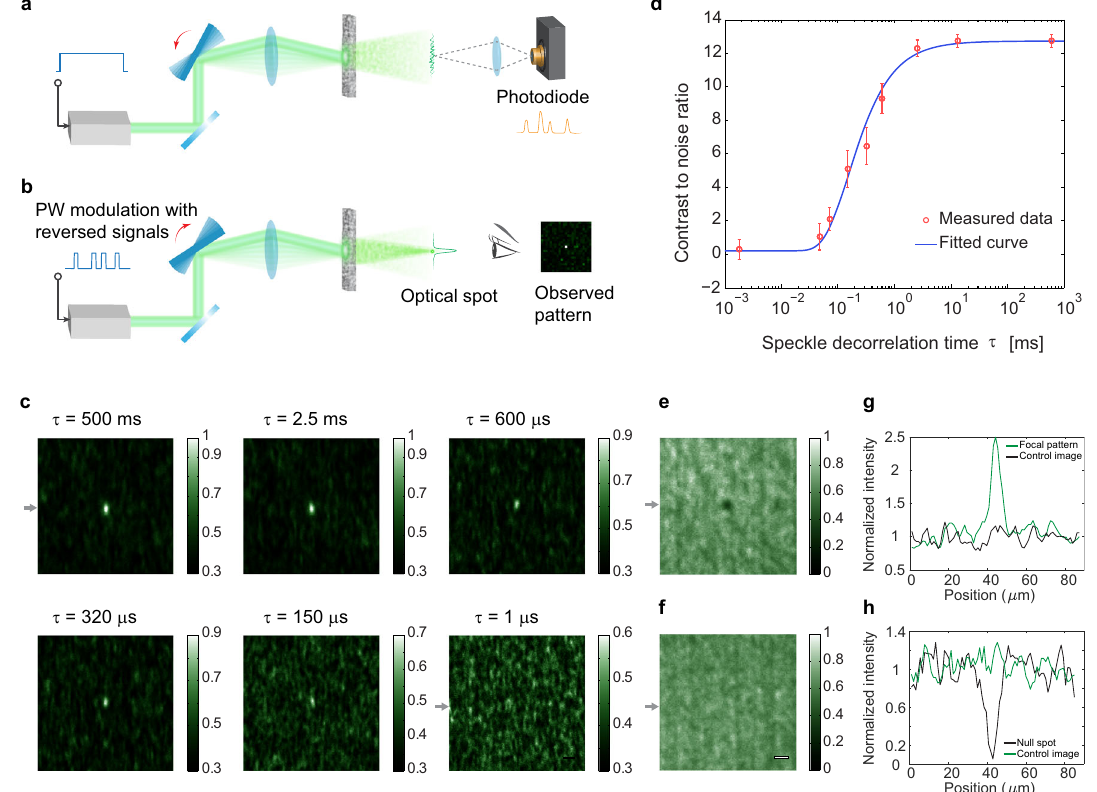
Fig. 3 Results of the feedback-based OCIS. a Simpli fi ed system setup for measurement. A galvo mirror was used to steer light into different channels of the scattering sample. As the galvo mirror scanned forward, the photodetector measured the temporal signal that fl uctuated as light (continuous wave) coupled into different channels. b The measured signal was binarized and used to modulate the intensity of the laser in a time-reversed order as the galvo mirror scanned backward. In this case, we can measure the optical channels and inject light (PW, pulsed wave) into the bright channels during a galvo mirror round trip. c At different sample decorrelation times, optical spots were created in free space and captured by a camera with an exposure time of 125 μ s. The CNRs for τ from 500 ms to 1 μ s are 12.6, 12.3, 9.3, 6.5, 5.1, and 0.3. Scale bar: 20 μ m. d CNR as a function of the sample decorrelation time. The error bar indicates the standard deviation of four points. e , f Feedback-based OCIS for null energy display. e By injecting light into the dark optical channels instead of the bright ones, we can obtain a null energy spot on the target plane. f Control image. By sending light into randomly selected channels, no null energy spot was observed. Scale bar: 20 μ m. g Line plots of the arrow-indicated lines in ( c , τ = 500 ms and 1 μ s), normalized by the mean value of the background. h Line plots of the arrow-indicated lines in ( e , f ), normalized by the mean value of the